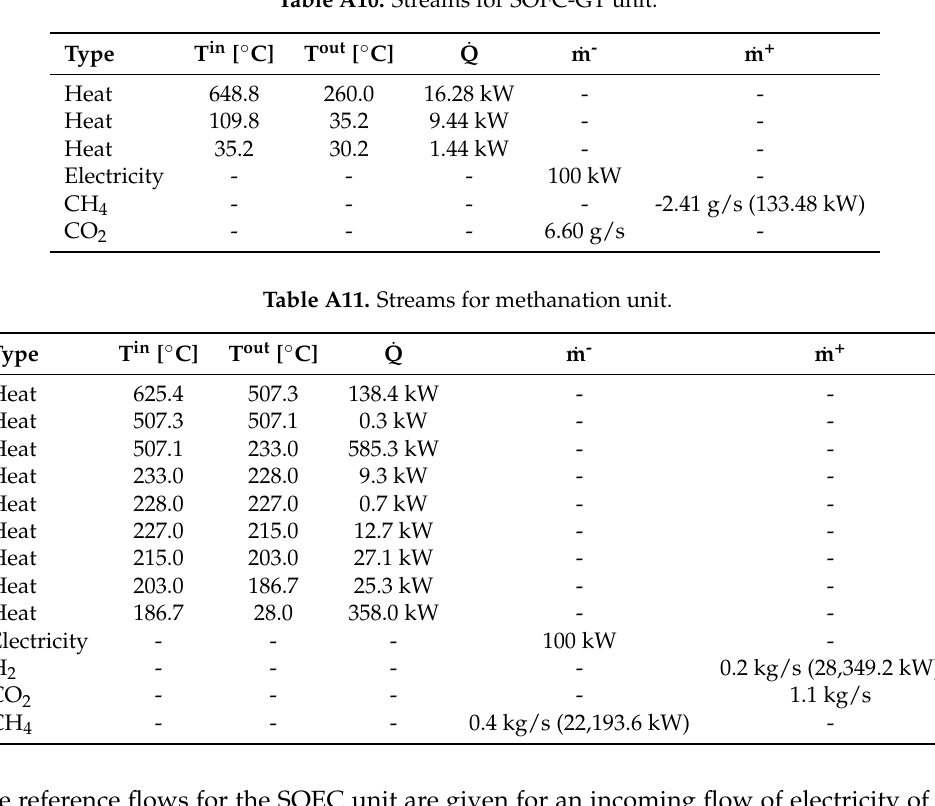
Table A10. Streams for SOFC-GT unit.